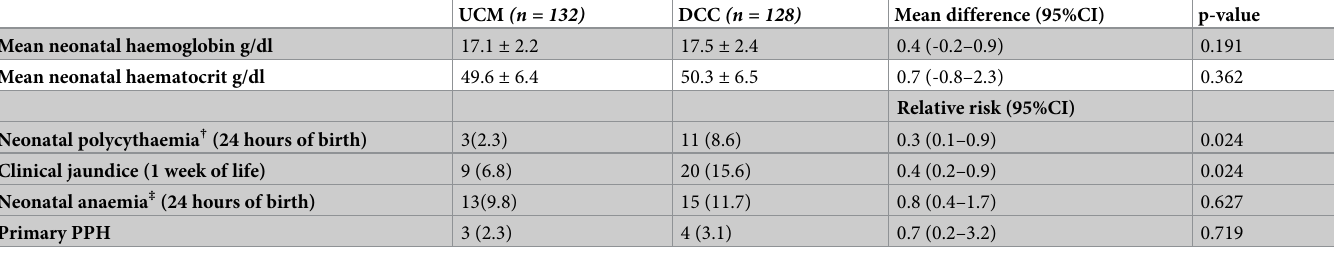
Table 2. Clinical and laboratory outcomes of trial participants who underwent umbilical cord milking versus delayed cord clamping between March 2018 to May 2019 at Kenyatta National